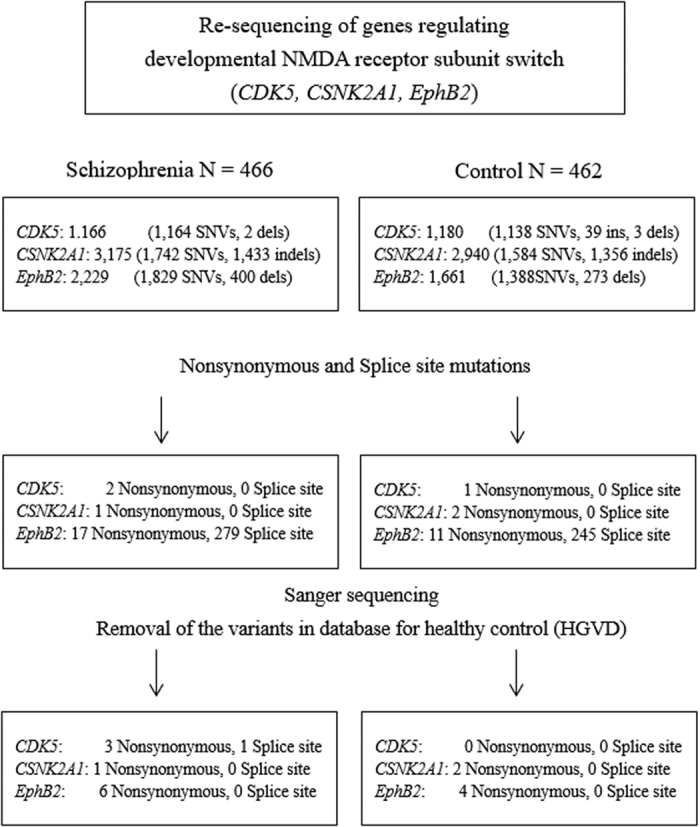
Flow diagram of processes used to detect single nucleotide variations (SNVs) and insertions and deletions (indels) in N-methyl-d-aspartate (NMDA) receptor switching regulator genes in patients with schizophrenia (SCZ) and in controls. Target re-sequencing of entire coding regions and splice sites (±5 base pairs) were performed. All detected nonsynonymous variants and regions with low coverage (<20), with no available designed amplicons were examined by Sanger sequencing. After sample quality control, 8 patients and 13 controls were excluded due to low DNA quality. Three nonsynonymous and one splice region variant in CDK5 were observed in patients with SCZ but not in controls. Nonsynonymous variants of CSNK2A1 and EphB2 were identified in both patients with SCZ and controls.